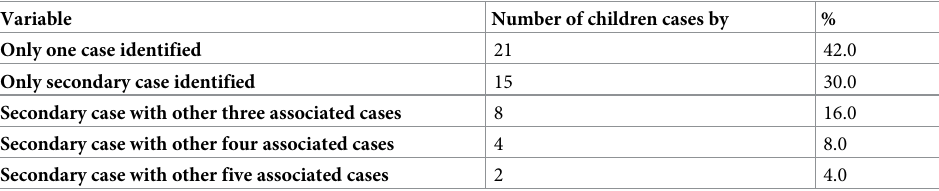
Table 7. Position of the child within the focus of transmission (n =